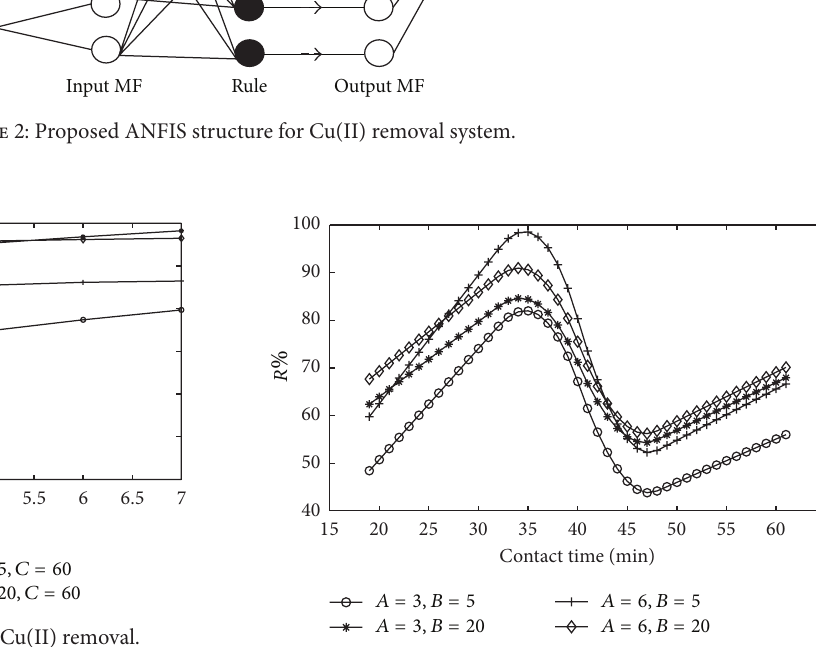
Figure 5: The effect of contact time (min) on Cu(II)